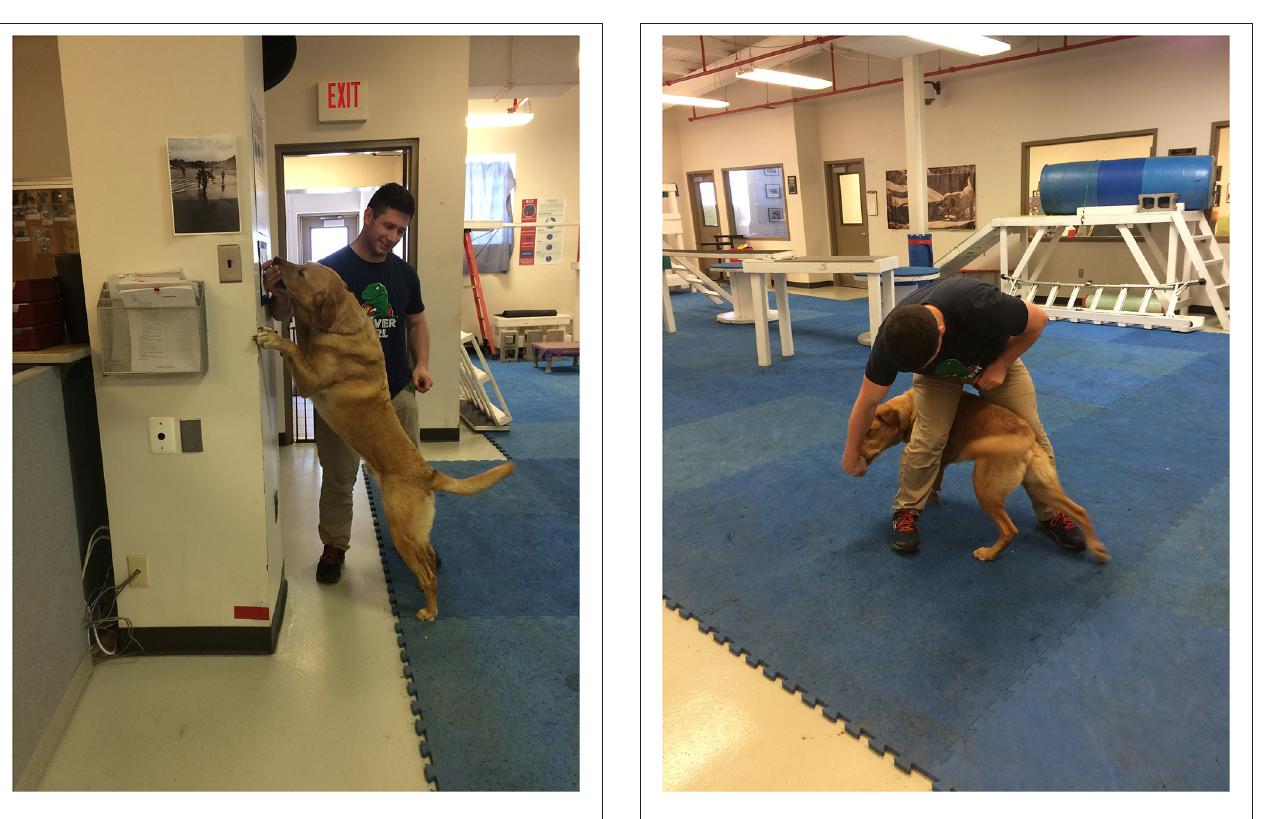
FIGURE 5 | Paws up stretch. FIGURE 6 | Figure eight stretch.